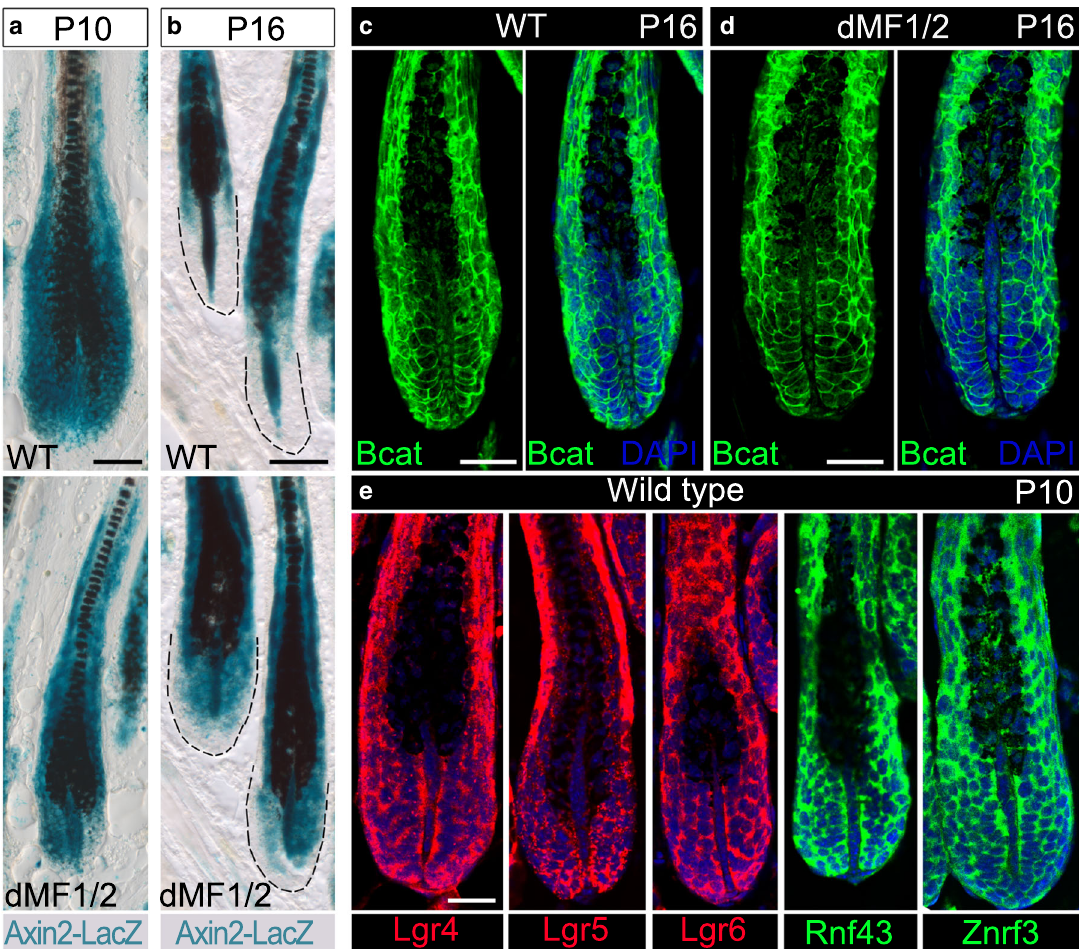
Fig. 4 Wnt signaling activity during mid-to-late anagen is progressively decreased only in the matrix to promote catagen induction. a X-Gal staining in skin sections from wild-type (upper panel) and Fgfr1/2 double mutant (lower panel) mice shows LacZ expression at P10. Note that Wnt signaling activity is readily detected in both the matrix and DP regardless of the genotype. Also note the comparable signal between the DP and the matrix. n = 3 mice per genotype. b X-Gal staining during late anagen (P16) revealed that Wnt activity in the wild type (upper panel) is diminished in the matrix but persists in the DP. By contrast, Wnt activity in the mutant (lower panel) persists in both the matrix and DP. Note however the signal in the DP is higher than the matrix. The dashed black line demarcates the boundaries of the follicle. n = 5 mice per genotype. c , d Immunostaining for beta-catenin during late anagen is shown to illustrate the presence of activated beta-catenin in the nuclei of DP cells in both wild-type ( c ) and mutant ( d ) littermates. For each genotype, the same follicle is shown twice: on the left, only beta-catenin fl uorescent image is presented, and on the right, a merge of beta-catenin and nuclear staining (DAPI) is displayed. n = 6 mice per genotype. e Wild-type skin sections from P10 mice were used to immunostain all the components of the machinery required to transduce Rspondin activity. Nuclei are in blue (DAPI). Note that none of these components is detected in the DP. n > 3 mice. Scale bar in ( a , b ), 50 μ m. Scale bar in ( c – d ), 25 μ